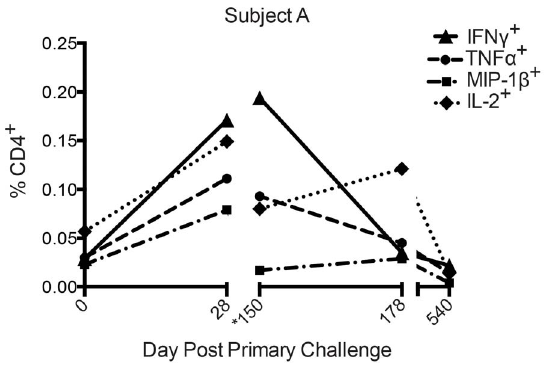
Figure 4. CD4 + T cells from protected Subject A produce proinflammatory cytokines following infection with live C. jejuni . PBMCs from pre-challenge (D0) and post-infection timeponts were stimulated with C. jejuni antigen in an ex vivo assay and assessed for CD4 + cytokine production by flow cytometry. Responses depicted represent the percentage of CD4 + T cells producing cytokine from CAg- stimulated PBMCs (CAg stimulation minus negative control). (*150= Day of homologous re-challenge.)